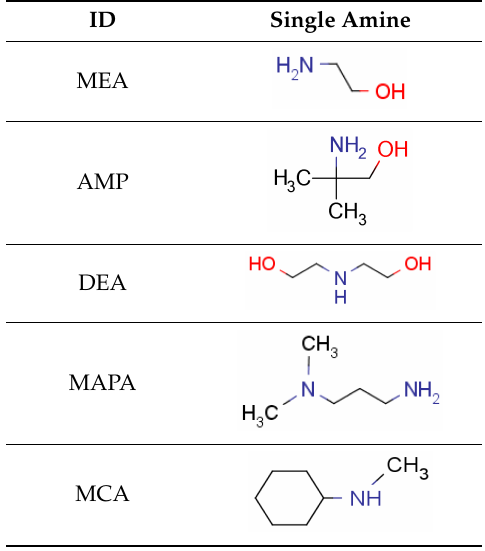
Table 2. Single solvents employed in this work. MCA is a phase-change solvent.